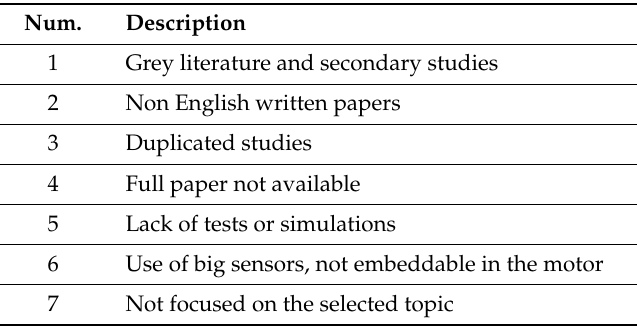
Table 9. Exclusion Criteria